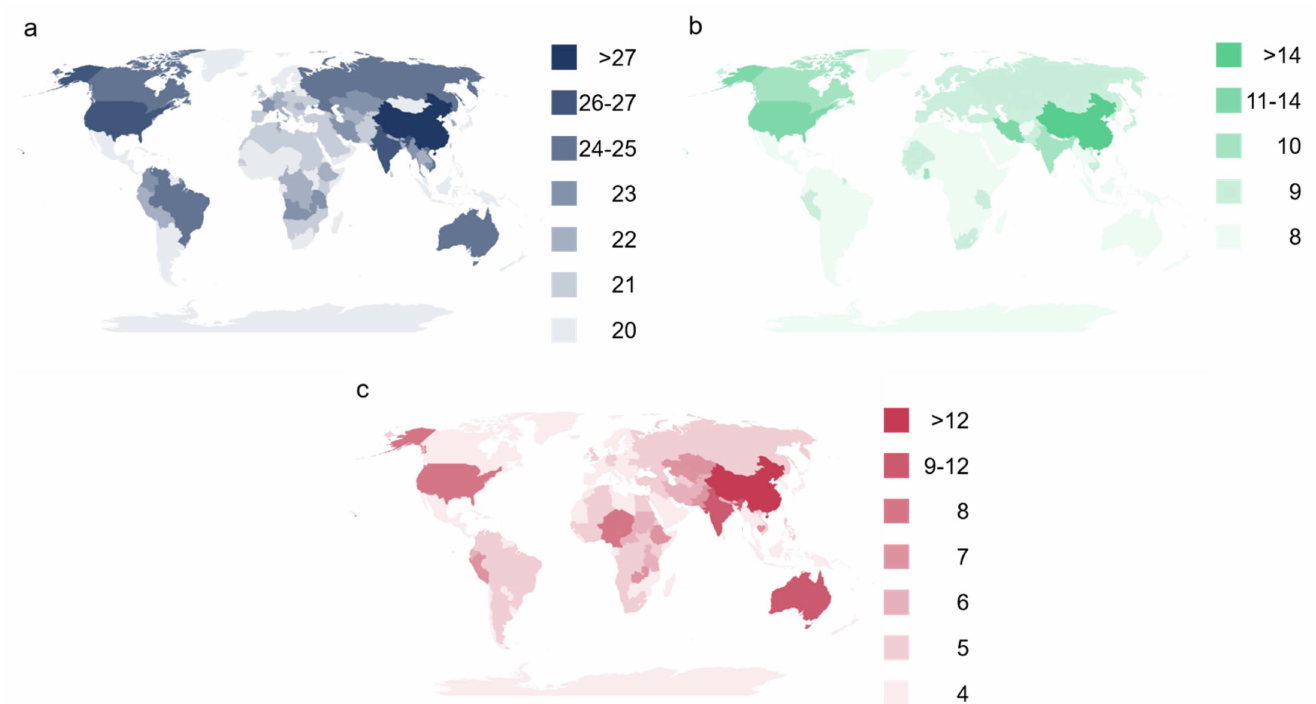
Figure 10. Number of studies mostly concerned with a thematic focus on hydrosphere ( a ), bio- sphere ( b ), and anthroposphere ( c